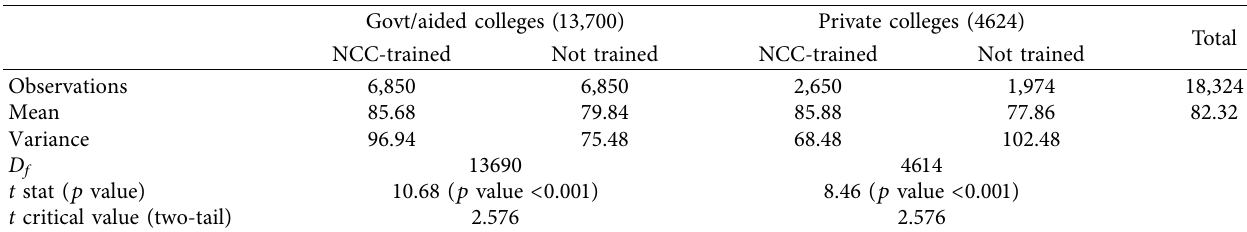
Table 7: Results of personality development qualities among govt and private colleges cadets in Madras